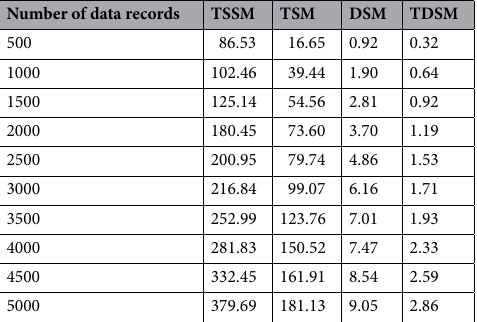
Table 5. Detailed information of data retrieval speed between TSSM, TSM, DSM and TDSM.